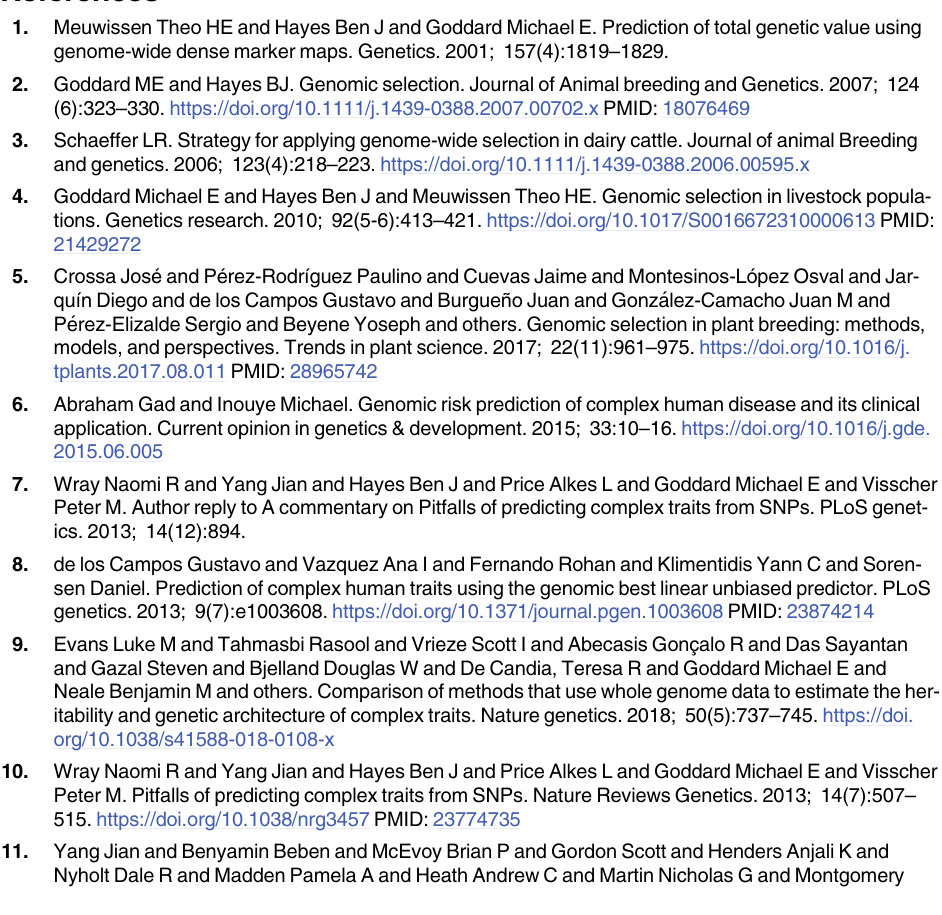
S2 Table. Predictive abilities estimated from five models across 35 traits. GBLUP, OBLUP, CBLUP, GOBLUP and GCBLUP. S3 Table. Statistical description of phenotype